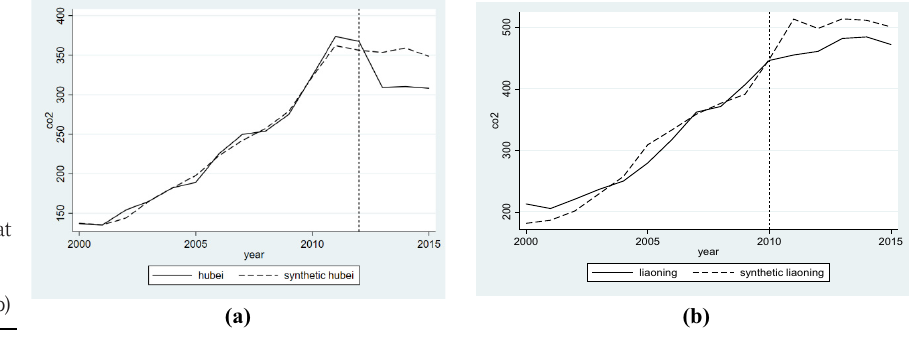
Figure 2. Comparison of total carbon emission of Hubei province (a) and Liaoning province (b) with that of synthetic Hubei province (a) and